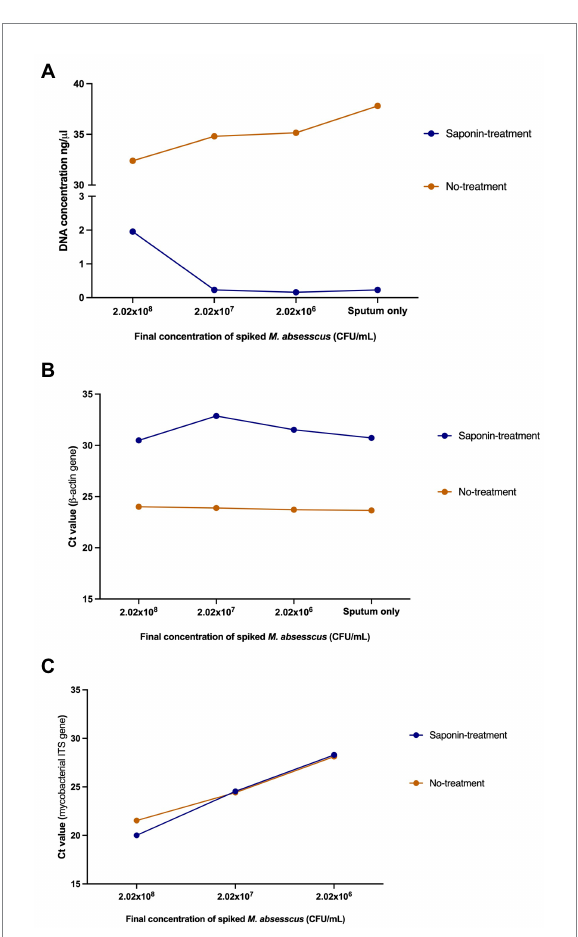
FIGURE 4 Effect of saponin treatment on human and M. abscessus DNA. (A) DNA quantification using Qubit TM v2.0, (B) qPCR targeting the human β -actin gene, and (C) qPCR targeting the mycobacterial internal transcribed spacer (ITS) on spiked human sputum (sputum